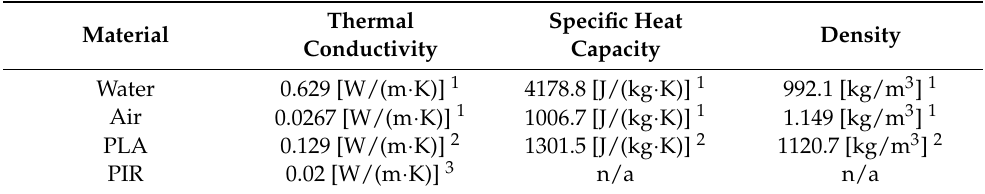
Table 1. Thermal properties of materials used in the experimental set-up. Material